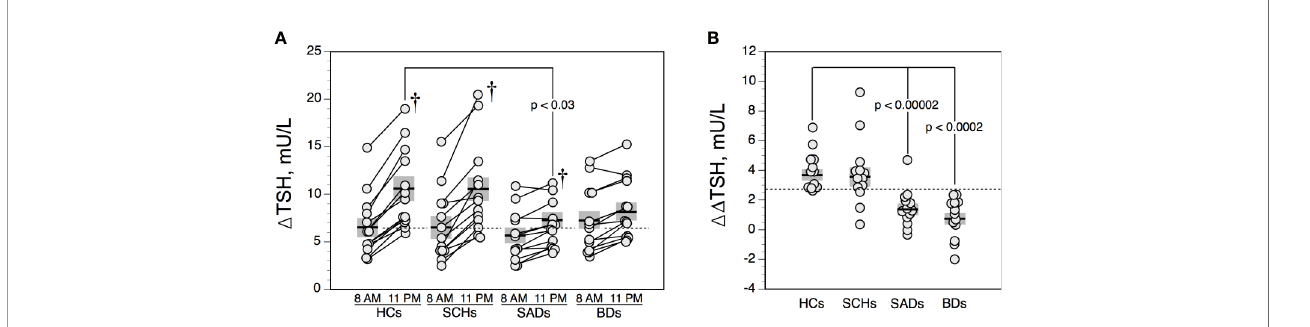
FIGURE 3 | Maximum increment in serum thyrotropin (TSH) level above baseline ( D TSH) after 200 m g IV of protirelin (TRH) (A) , and difference between 11 PM- D TSH and 8 A- D TSH ( DD TSH) (B) in controls and patients. The solid horizontal lines indicate the group mean; the shaded areas represent ± SEM. HCs, healthy control subjects; SCHs, patients with paranoid schizophrenia; SADs, patients with schizoaffective disorder; BDs, patients with bipolar depression. † p < 0.005 by T test (comparison between 8 AM- D TSH and 11 PM- D TSH values).